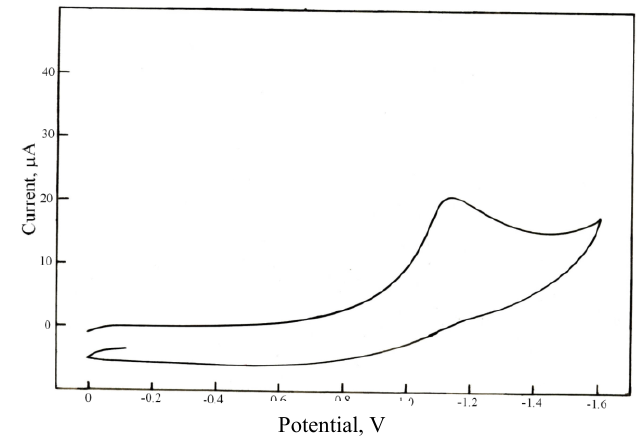
Figure 2: Cyclic voltammogram of N'-(p-toluenesulphonyl)-3-methyl-4- (arylhydrazono) pyrazolin-5-one. pH = 4.0; Scan rate = 0.05 VS -1 .